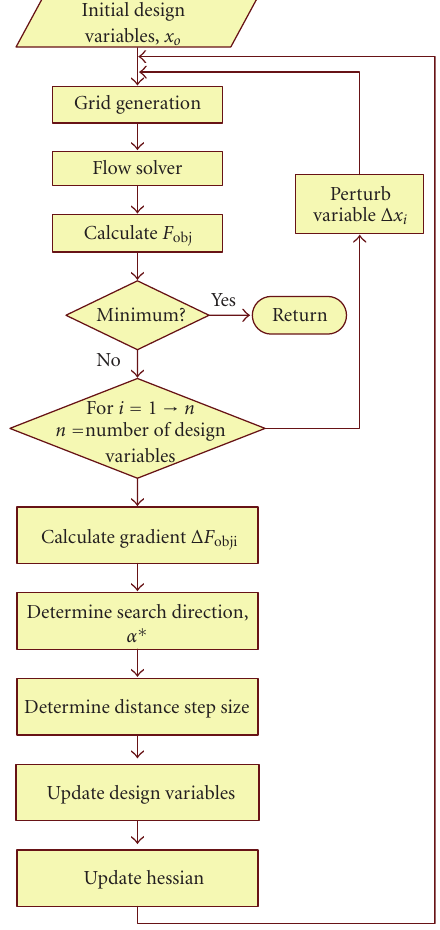
Figure 14: Flowchart of optimization routine. Table 5: Table of optimized geometry and magnetic field angles for stationary ionized